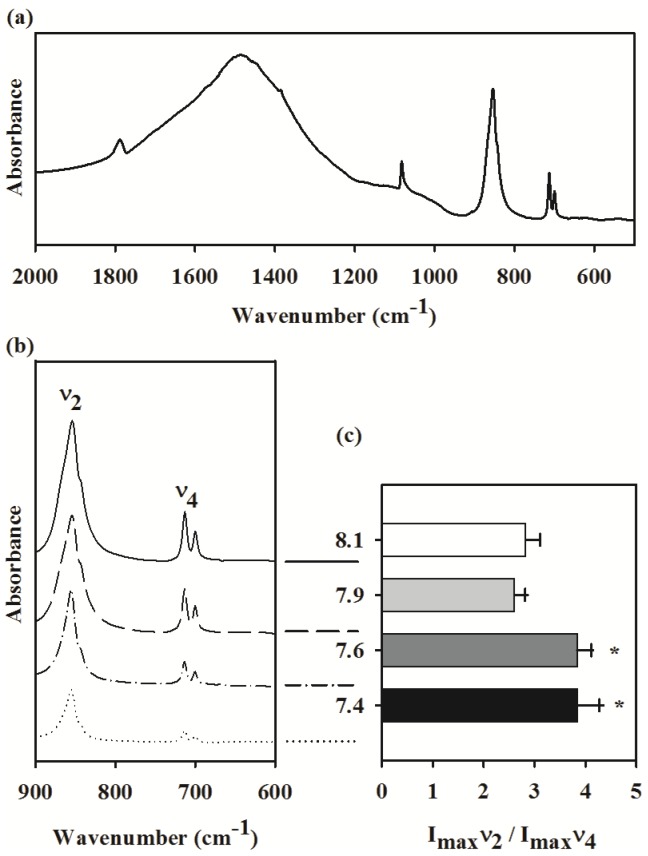
Effects of pH/pCO2 on shell mineralogy in the juvenile tubeworm, Hydroides elegans.(a) The infrared absorption spectrum obtained from shell samples of the control pH/pCO2 (pH 8.1) using the Fourier transform infrared spectrometry (FT-IR). (b) Effects of pH/pCO2 on the magnified portion, between wavelengths 600–900 cm−1, of infrared spectral pattern of the shell. (c) Effect of pH/pCO2 on the intensity ratio (Imax) of the two absorption peaks at 855 cm−1 (ν
2) and 713 cm−1 (ν
4). The Imax
ν
2/Imax
ν
4 ratio is an indicator of amorphous calcium carbonate (ACC) content. Each bar represents the mean ± SD of 5 biologically independent measurements. The asterisk (*) shown on the bar indicates a significant difference between the control and the treatment according to the Dunnett's Post-hoc test (p<0.05).